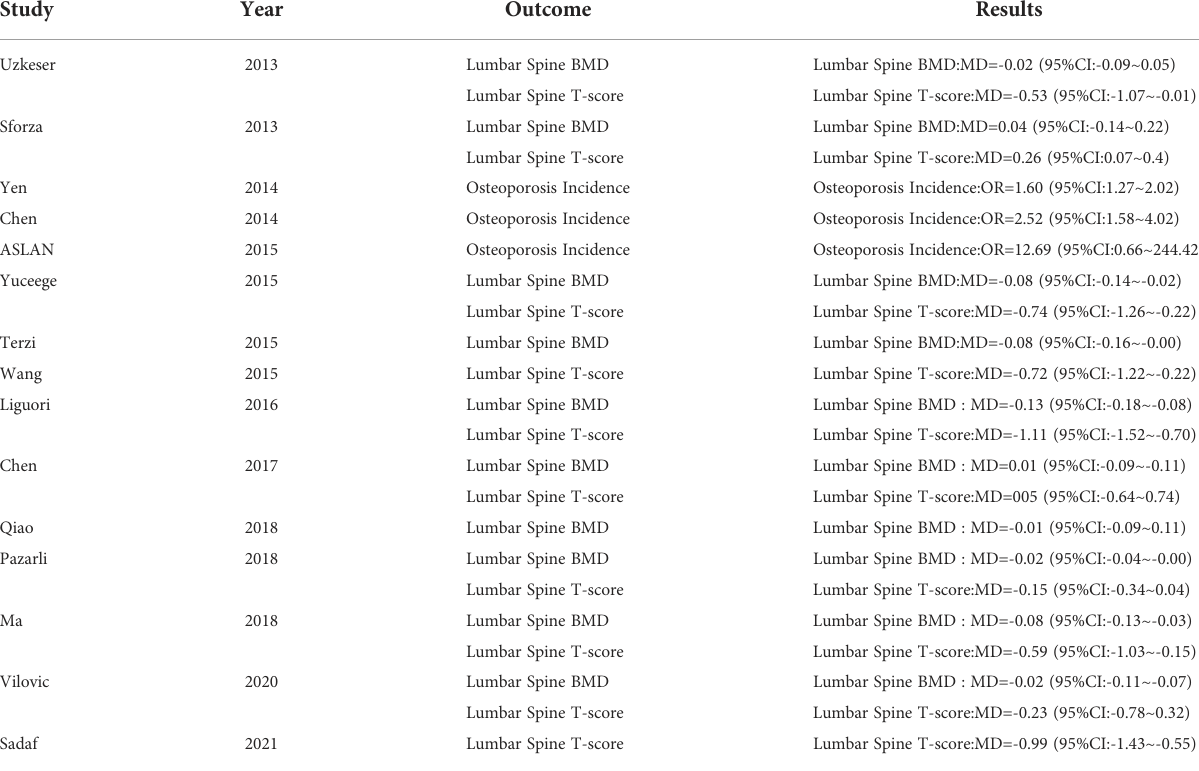
TABLE 3 The effect size value for mean differences of the included